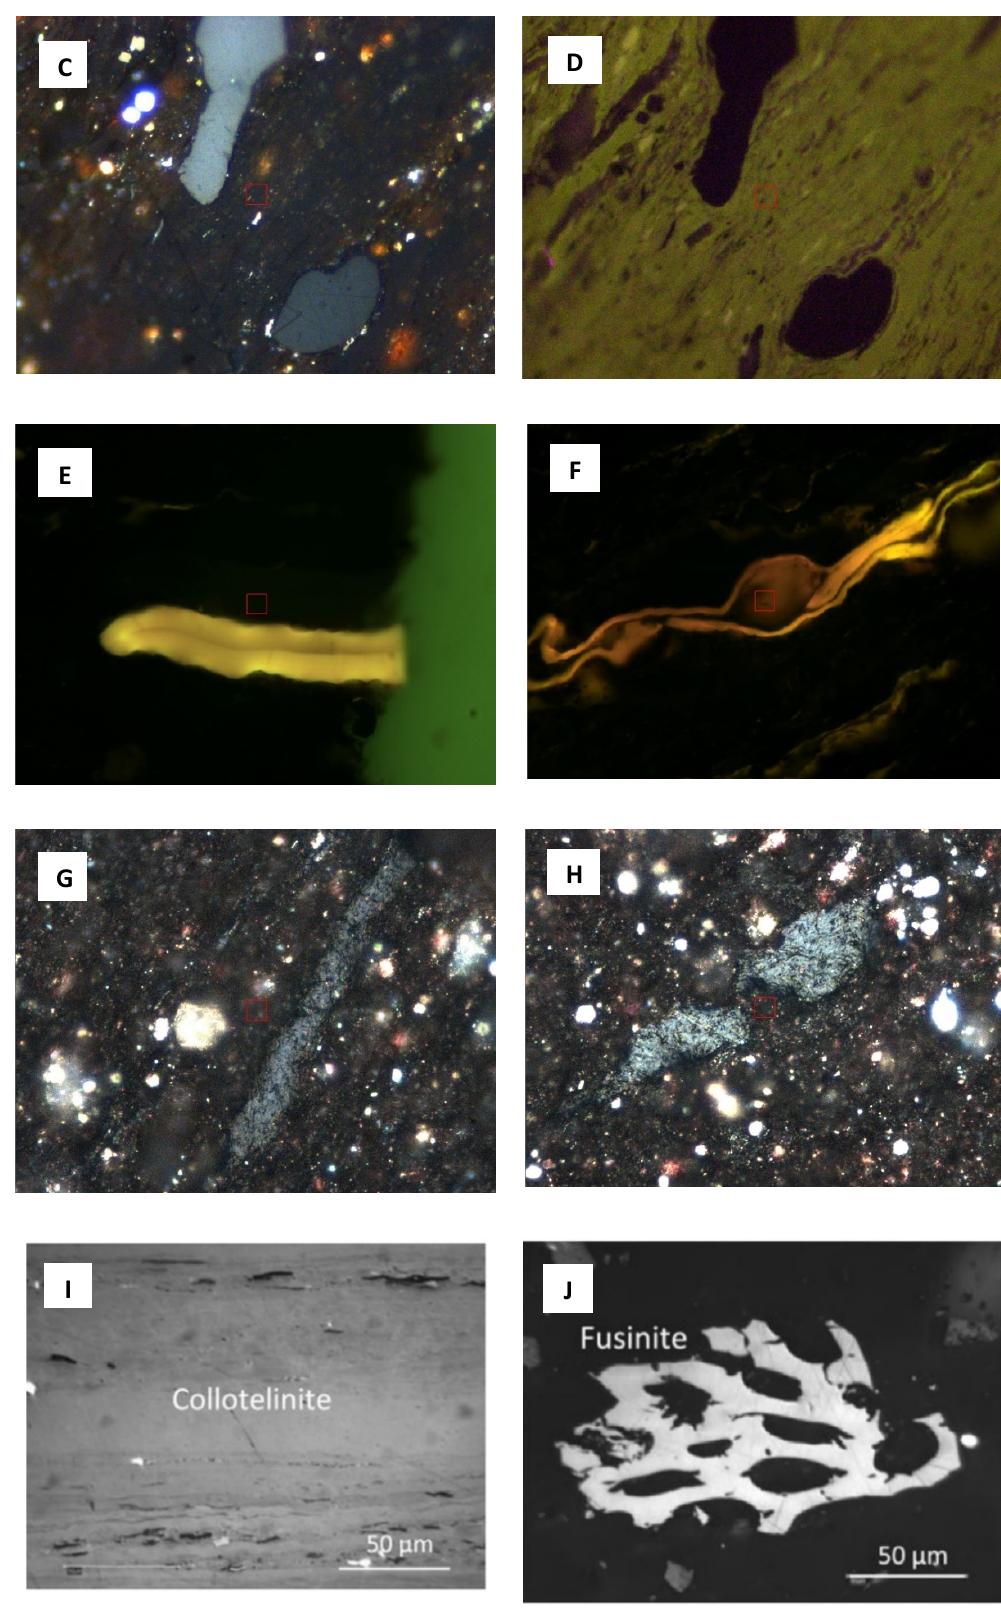
Figure 2. ( A ) Inertinite particles (gray) in a matrix of amorphous organic matter (AOM); ( B ) the same view under UV (ultraviolet) light. Inertinite particles have no fluorescence, but the AOM is recognizable with yellowish-green fluorescence; ( C ) inertinite particles (gray) in a matrix of lamellar algal matter and AOM; ( D ) the same view under UV light. Lamellar algal matter is recognizable by